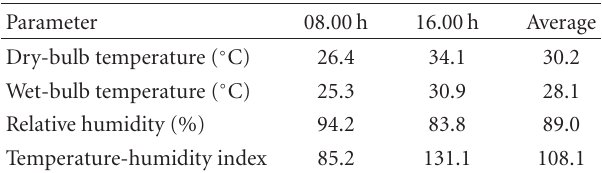
Table 2: Average daily values for meteorological parameters observed during the experimental period.